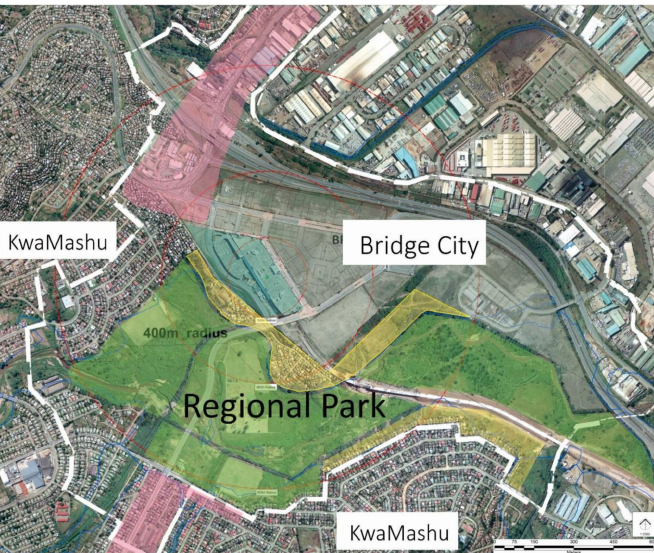
Figure 1. An aerial photograph showing the Bridge City KwaMashu Open Space Project as a “regional park” that is located within the KwaMashu Urban Hub Project. Source: